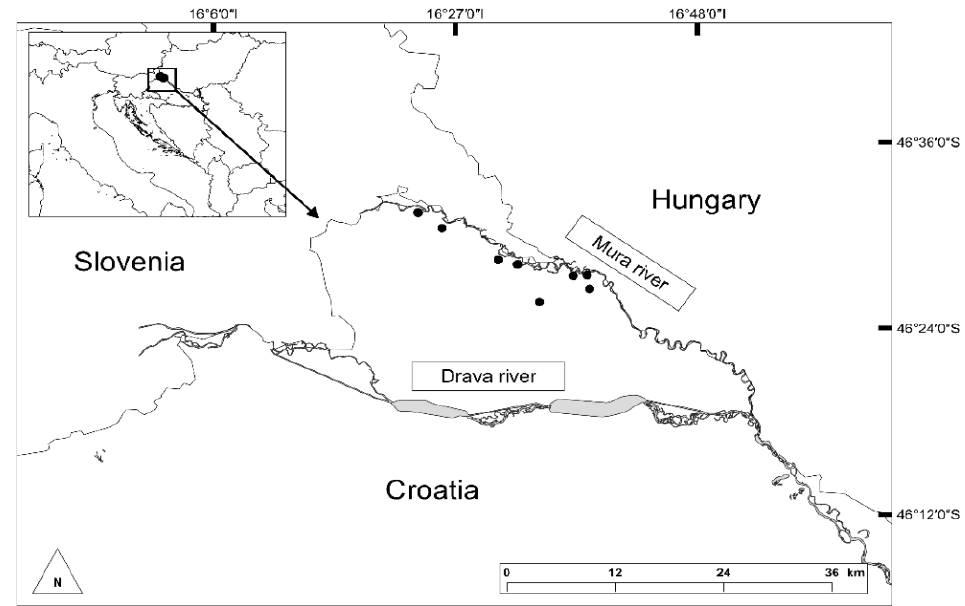
Figure 1. The sampling micro locations of Himalayan balsam honey along the Mura River in Croatia.